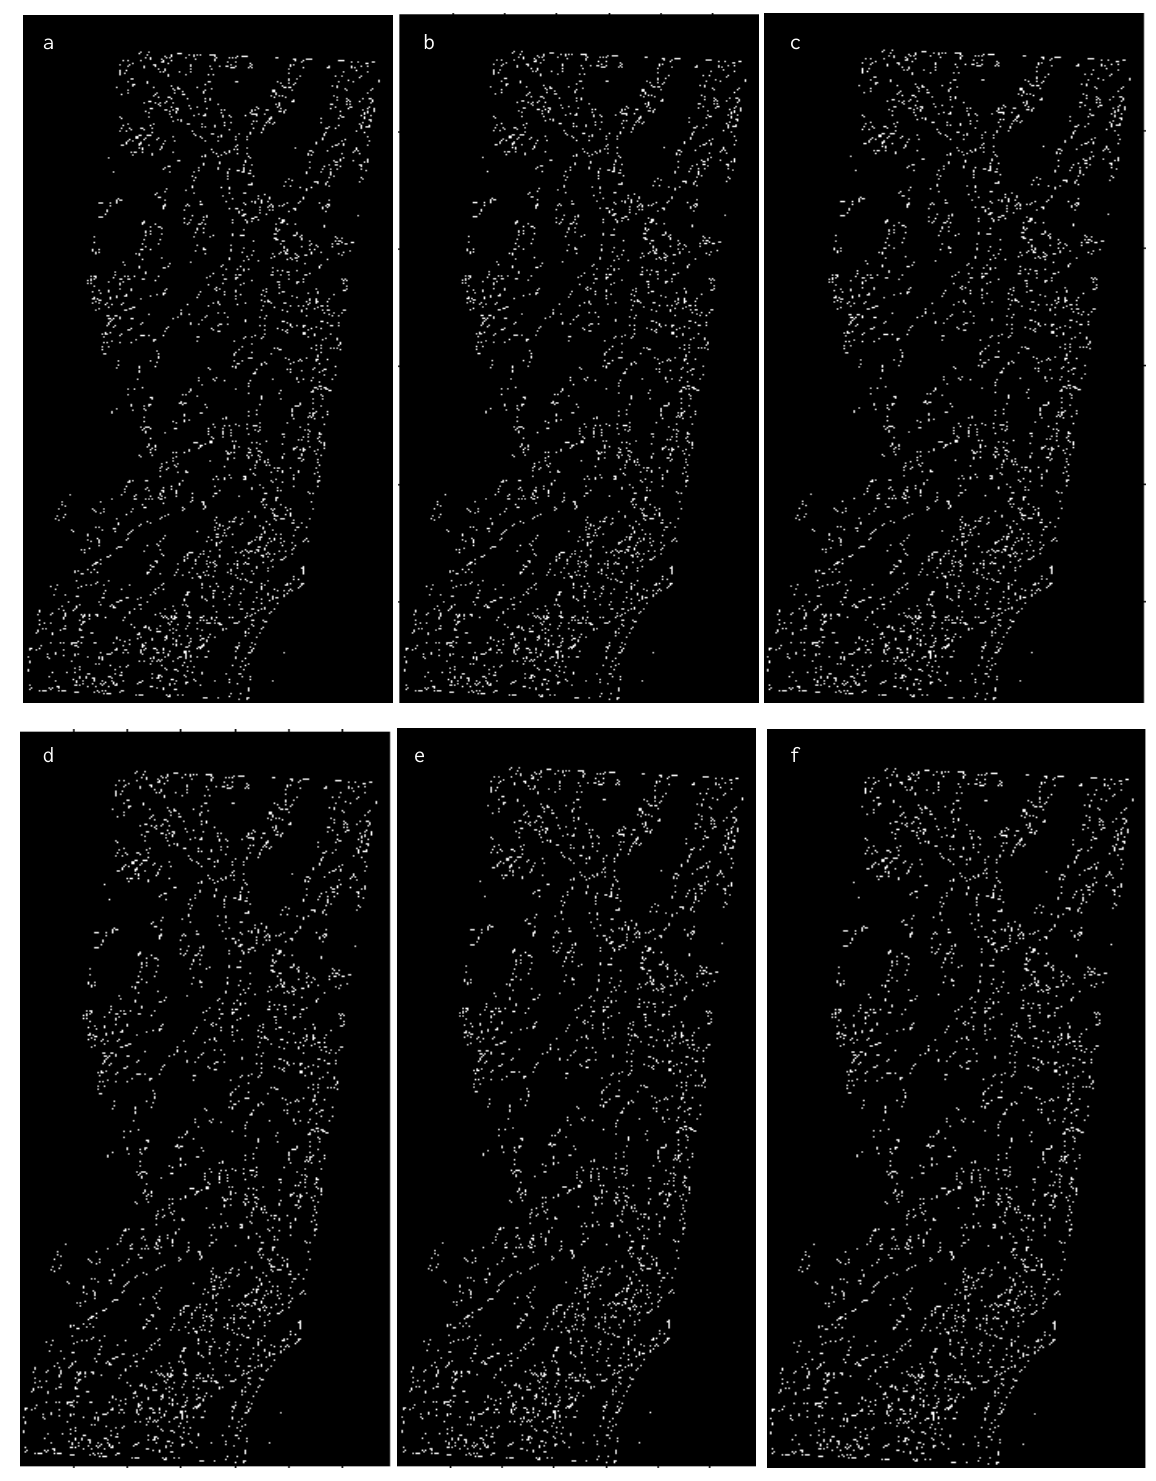
Figure 4. Edges for test case 2 by proposed algorithm at